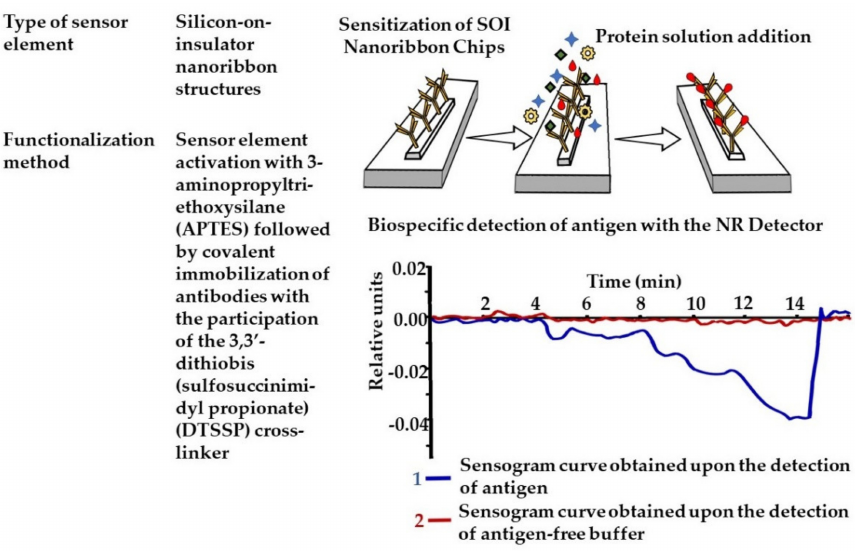
Figure 6. Label-free nanoribbon (NR)